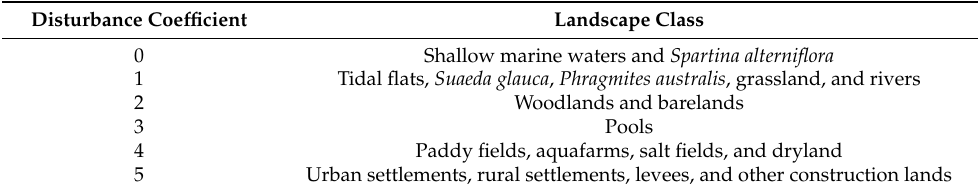
Table 1. The human disturbance coefficients of the different landscapes in the study